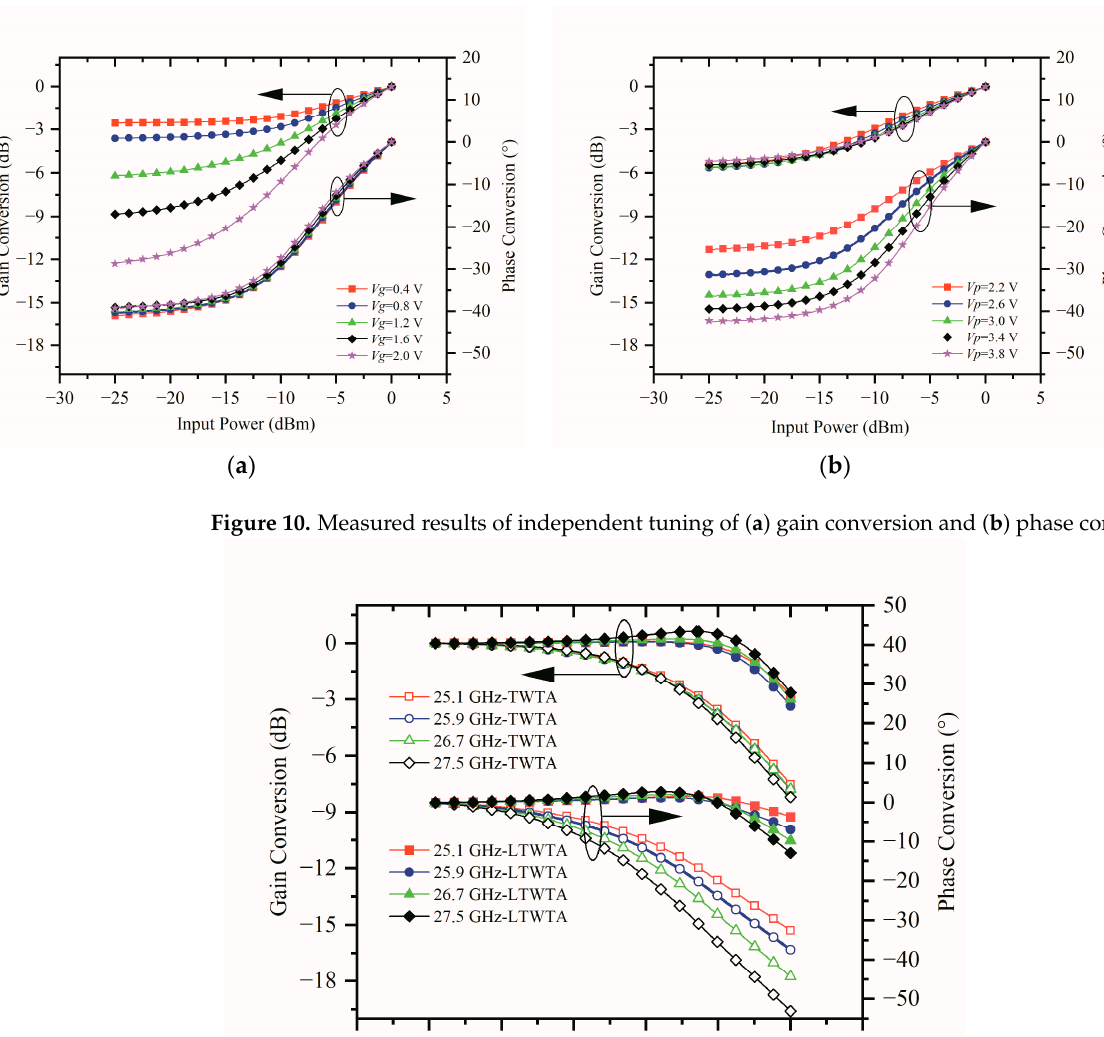
The output power fallback of the LTWTA under the same C/IM3 value of 28 dBc was 5 dB lower when compared with that of the TWTA. That is to say, the LTWTA can operate at a higher power state and its efficiency is also higher. When the output power fell back 3 dB over the whole operating band 25.1~27.5 GHz, the minimum and maximum C/IM3 values were 28 dBc and 33 dBc. The difference was not more than 5 dB, which indicates that the linear module has good broadband adaptability.